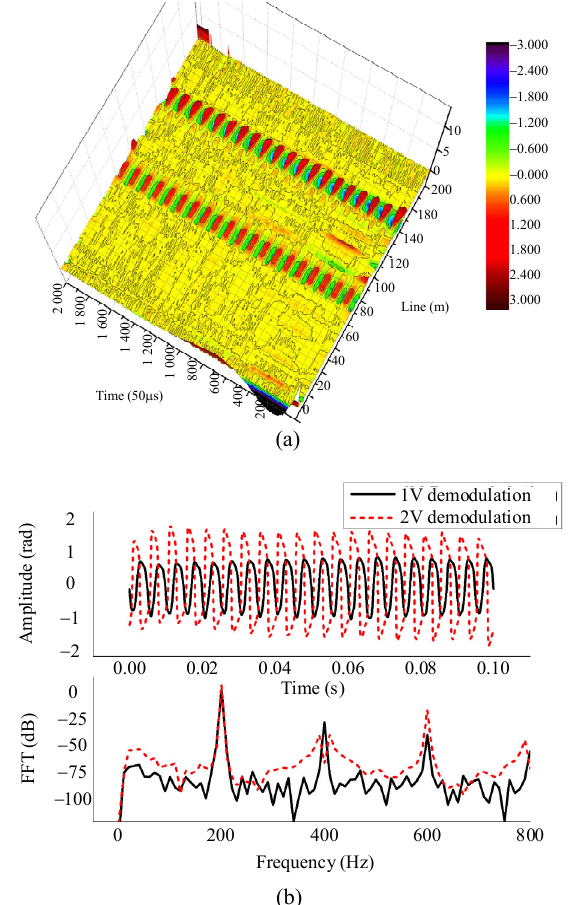
Fig. 3 Demodulated scalograms of (a) two 200 Hz acoustic events, with an amplitude of 1 V at the 100 m position and an amplitude of 2 V at the 160 m position, respectively and (b) time and frequency responses of the two demodulation results.